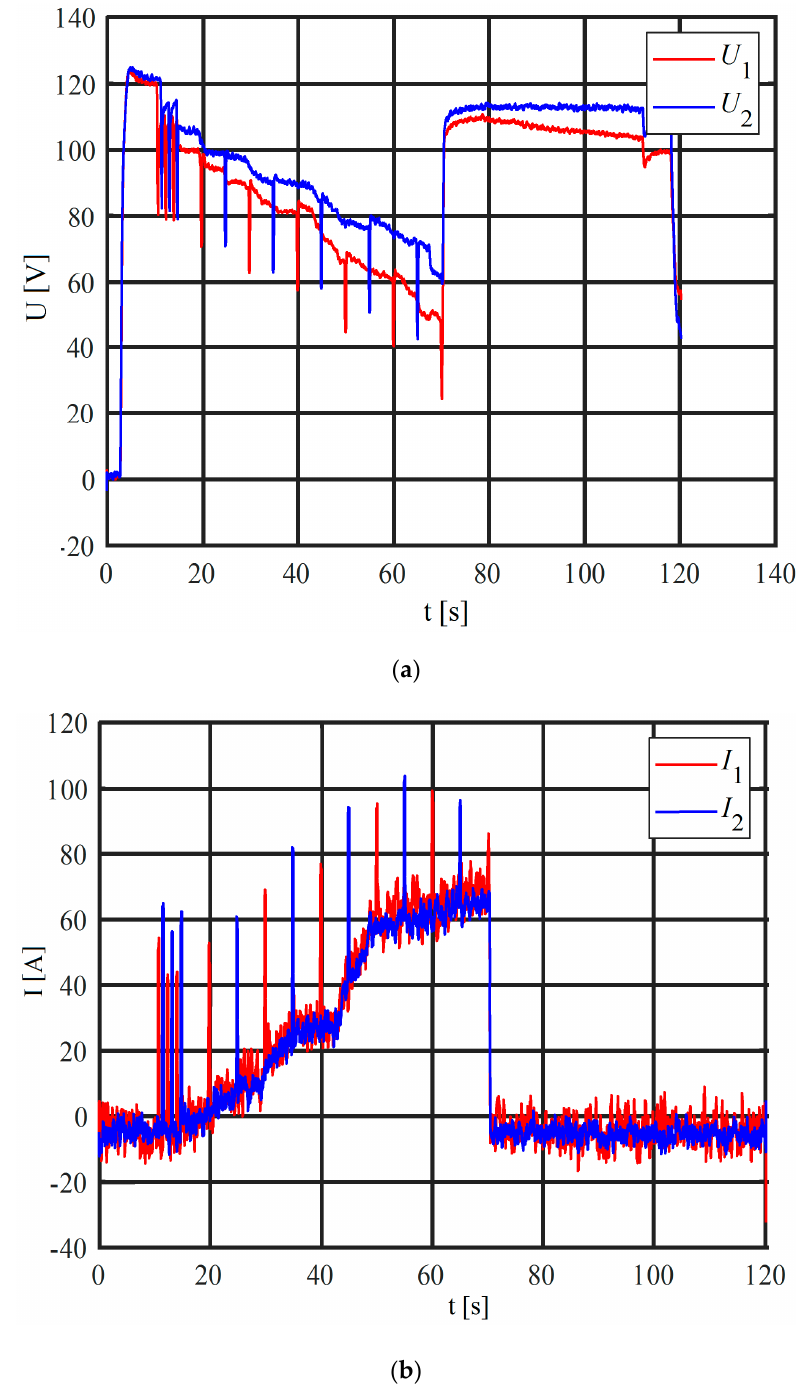
Figure 17. ( a ) Voltage (U1 and U2) vs. time recorded during investigation of the safety procedures of two-module PEMFC stack operation. ( b ) Current (I1 and I2) vs. time recorded during investigation of the safety procedures of two-module PEMFC stack operation .